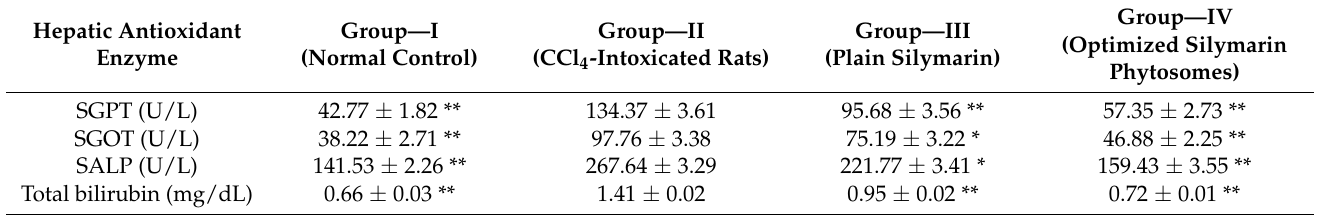
Table 3. Hepatic marker enzymes levels following treatment with plain silymarin and optimized silymarin phytosomal formulation in CCl 4 -intoxicated rat